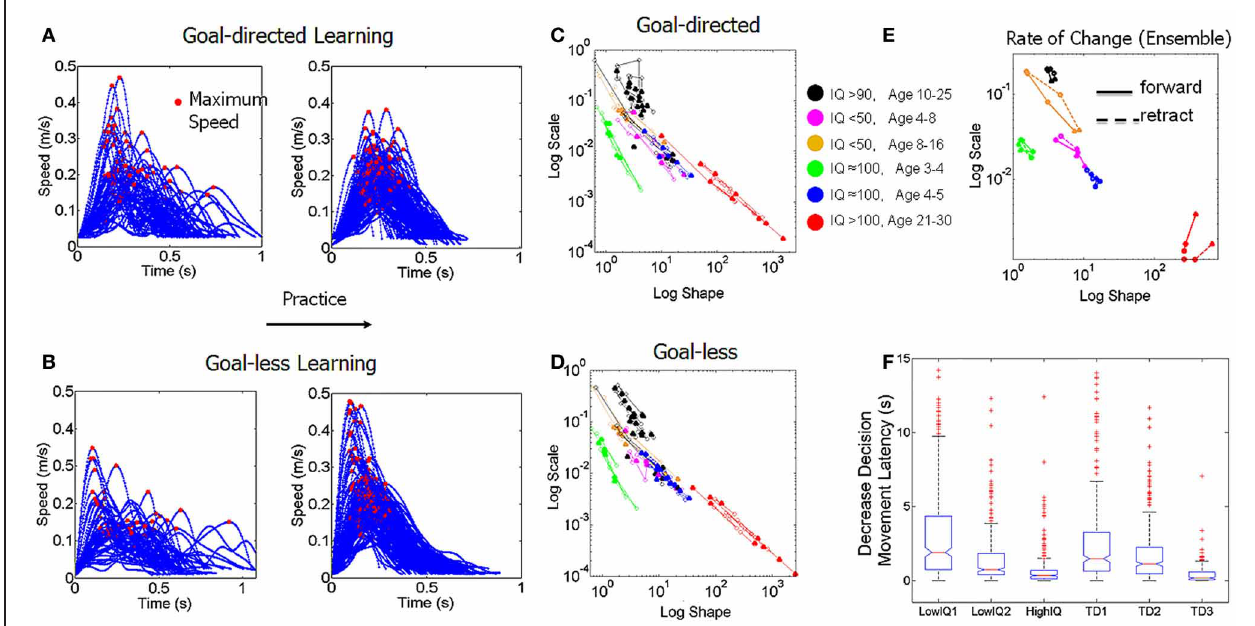
FIGURE 9 | Dynamically tracking the micro-movements as a function of decision-making. (A) Speed profiles from a pre-school TD participant showing how changes in cognitive load of the decision-making task initially evoked multiple peaks in the hand velocities to the target, yet unimodality returned within minutes of practice. The stabilization also manifested in the goal-less segments (B) . (C) log-log plot of trajectories of the rate of change in the stochastic signatures of the average movement speed in the goal-directed hand motions in each self-emergent statistical subtype of Figure 8A (depicted in the legend). Each individual manifested different responses to the change in cognitive load on the micro-movements, and